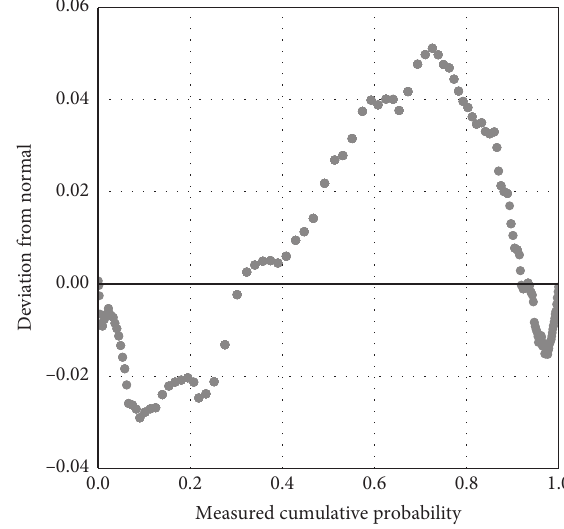
Figure 3: The normal P − P diagram of the Reaction time after natural logarithm transformation.